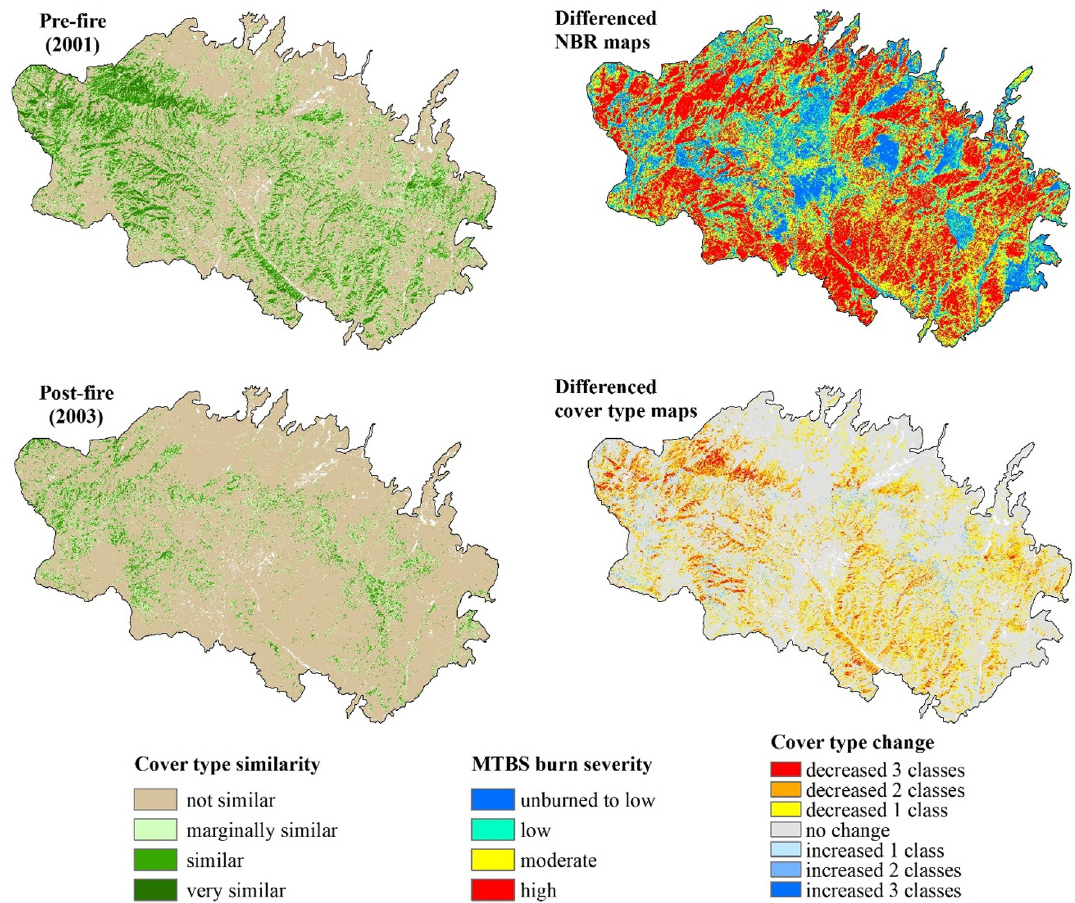
Fig 9. Effects of wildfire on cover type classes. Change detection within the Rodeo-Chediski fire (2002) comparing a MTBS burn severity map (top right) and a differenced cover type map (bottom right).